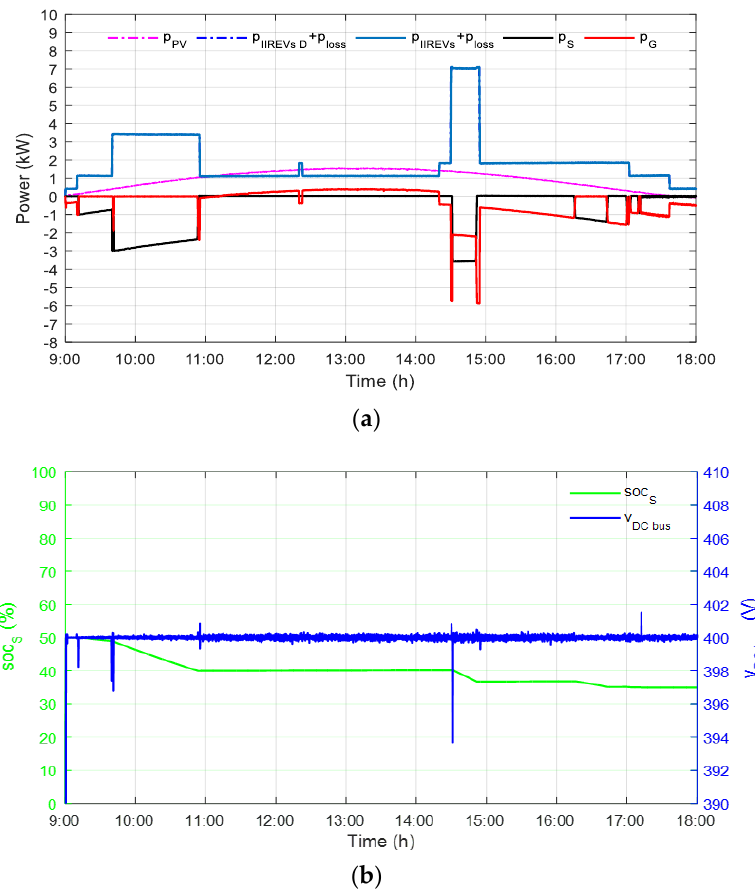
Figure 20. Power flow and storage state of charge for “real - time exp” with opt ( a ) and ( b ) storage state of charge and DC bus voltage — experimental test 1a.